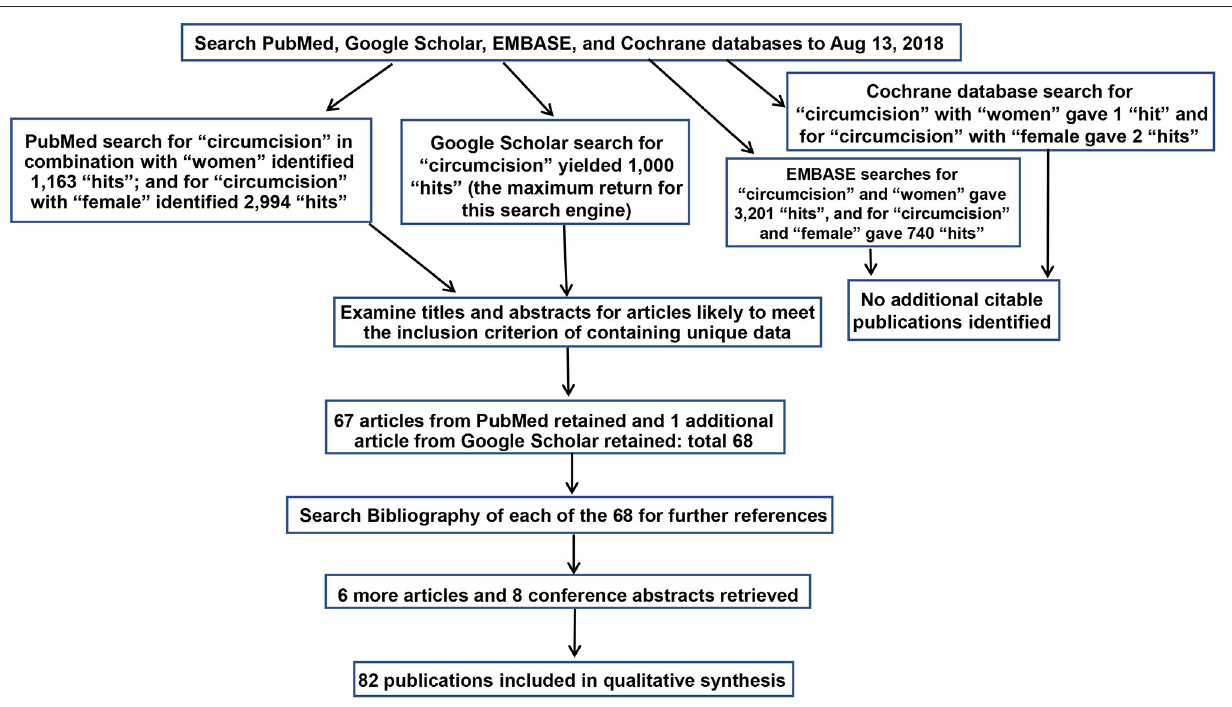
FIGURE 1 | Search strategy diagram as required by PRISMA guidelines